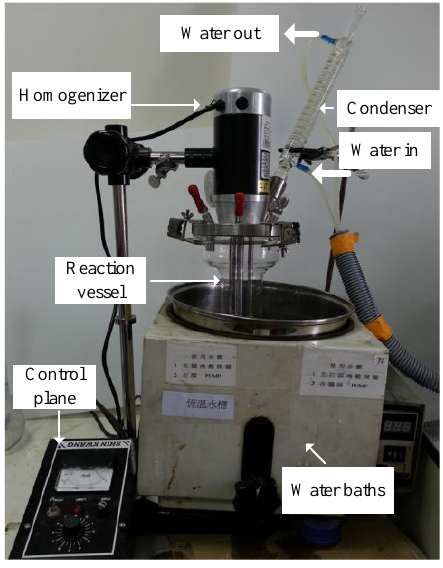
Figure 1. The experimental setup .